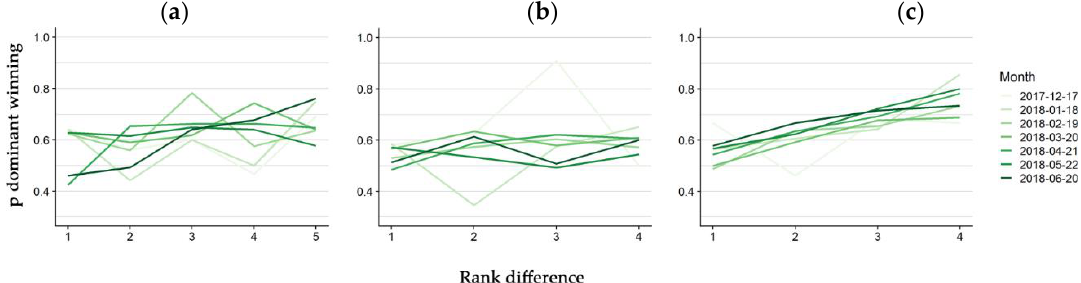
Figure 3. Hierarchy stability index of the three groups of hatchling European pond turtles. Black line: Group one. Green line: Group two. Red line: Group three.